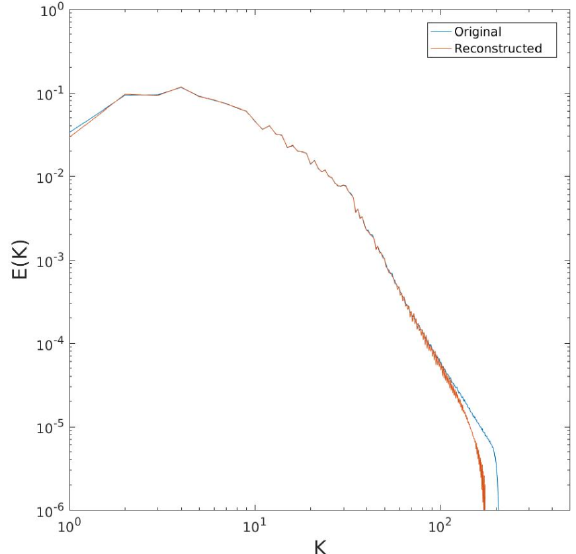
Figure 8. As in Figure 6, but with the reconstruction from the structure function based on (4).